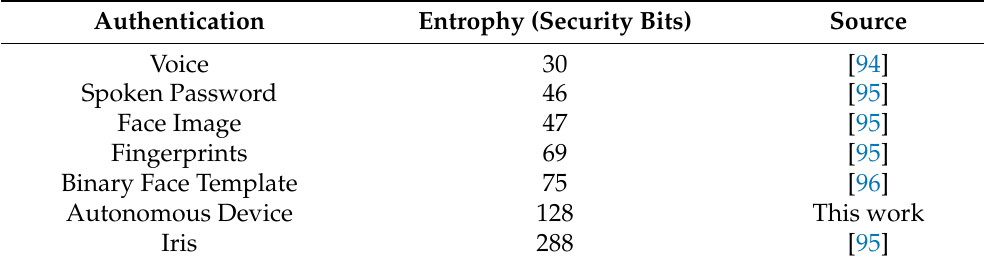
Table 5. Entrophy comparison of proposed solution with related